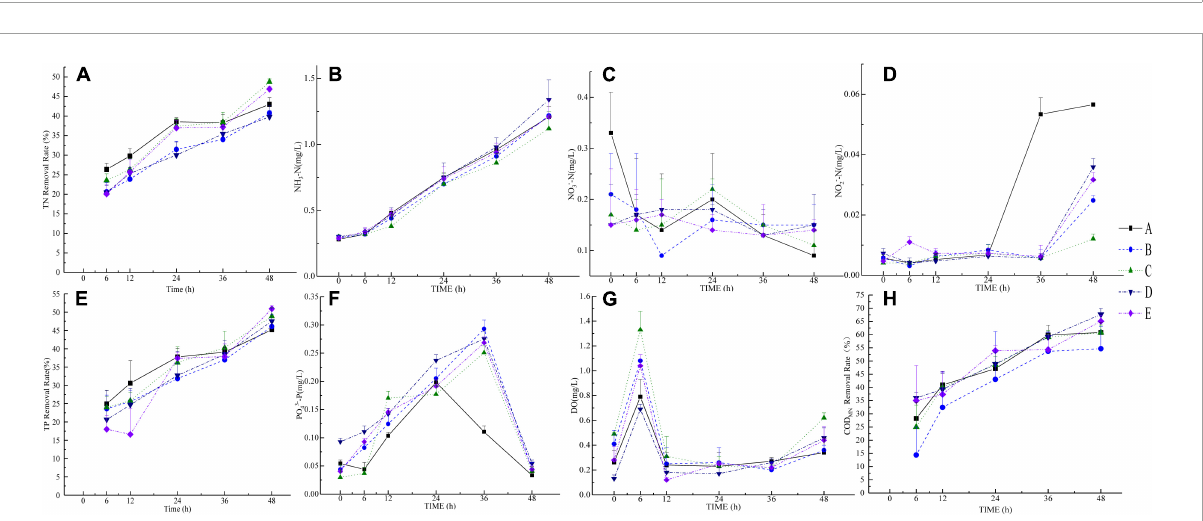
FIGURE2 Measurement results of eight water quality indicators. (A–H) pictures are TN (removal rate), NH 3 -N, NO 3 − -N, NO 2 − -N, TP (removal rate), PO 43 − -P, DO, and COD Mn (removal rate),